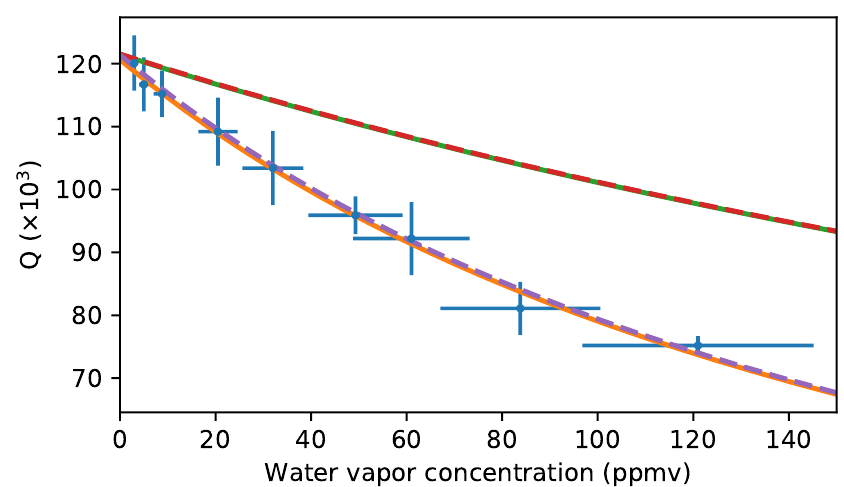
Figure 4. Measured Q-factors (blue dots with error-bars) as a function of water vapour concentration, with the corresponding fit (Equation (1), orange solid line). The calculated and simulated Q (ppmv) curves using the HITRAN database are shown with a green solid and red dashed lines, respectively. The simulated curve assuming a continuously growing water layer film on the disc is shown with the purple dashed line. The water layer is modelled as a Transition Boundary Condition with a uniform coverage of the disc, and an effective layer thickness. The dielectric function assumed for the liquid water layer is (cid:101) = 4.8 + i 3.2